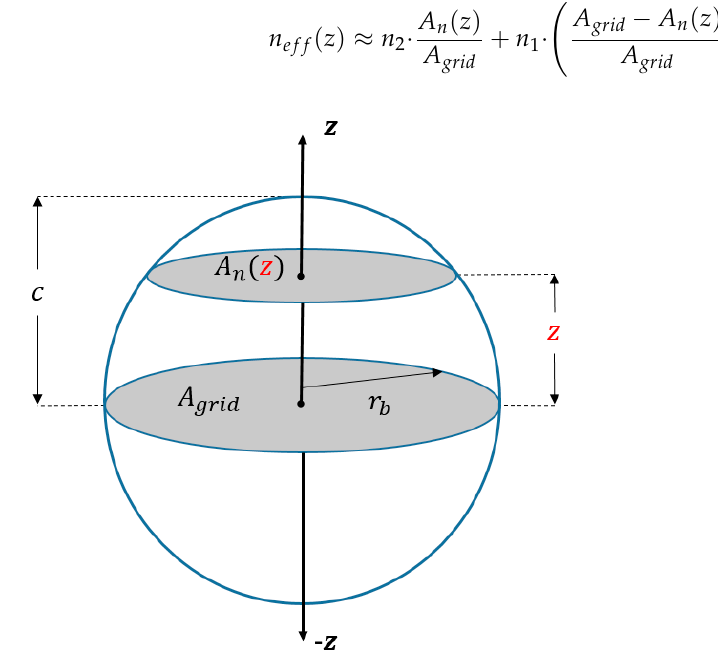
Figure 1. Shape geometry analysis for EMT calculations.